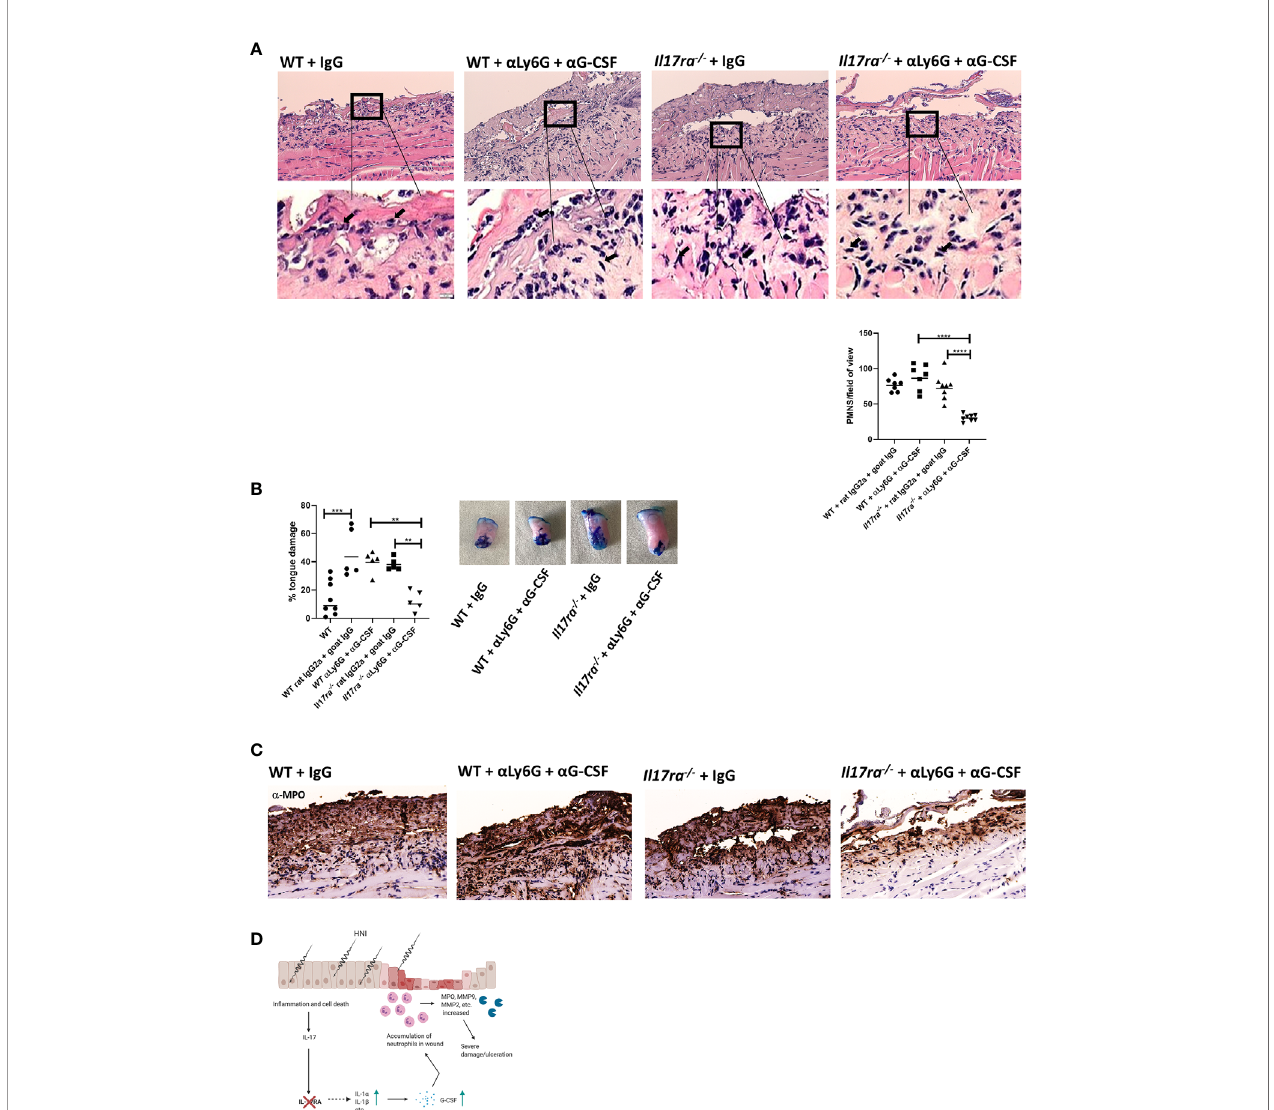
FIGURE 7 | Neutralization of neutrophils reduces damage in the absence of IL-17RA. Mice were treated i.p. with a Ly6G at 150 µg and a G-CSF at 10 µg (n = 5/ group) on day 7 following radiation. On days 8 – 10 mice were treated with 10 µg of a G-CSF. Control animals received appropriate isotype controls ( Supplementary Table 2 ). Data is representative of two independent experiments. (A) Staining by hematoxylin and eosin of sectioned tongues and quanti fi cation of neutrophils on day 11 following HNI. Images captured at 200 and 10 m M. Data analyzed by ANOVA with Tukey ’ s post hoc . (B) Tongues were harvested and damage quanti fi ed by toluidine blue+ staining on D11. Data analyzed by ANOVA with Tukey ’ s. (C) Representative MPO-staining of ulcer boundary counterstained with hematoxylin. (D) Proposed mechanism of IL-17RA-mediated protection and healing of OM. Radiation induces in fl ammation and apoptosis, increasing IL-23 expression. IL-23, in turn activates IL-17RA-mediated in fl ammation. In the absence of IL-17RA, IL-23, along with IL-1a synergizes to induce excess neutrophil chemokines like G-CSF resulting in accumulation of neutrophils in the damaged area. Increased neutrophils release proteases that further damage the wound and contribute to delayed wound healing. Image created using BioRender with permission. Data shown as means ± SEM, (**P < 0.01, ***P < 0.001, ****P <